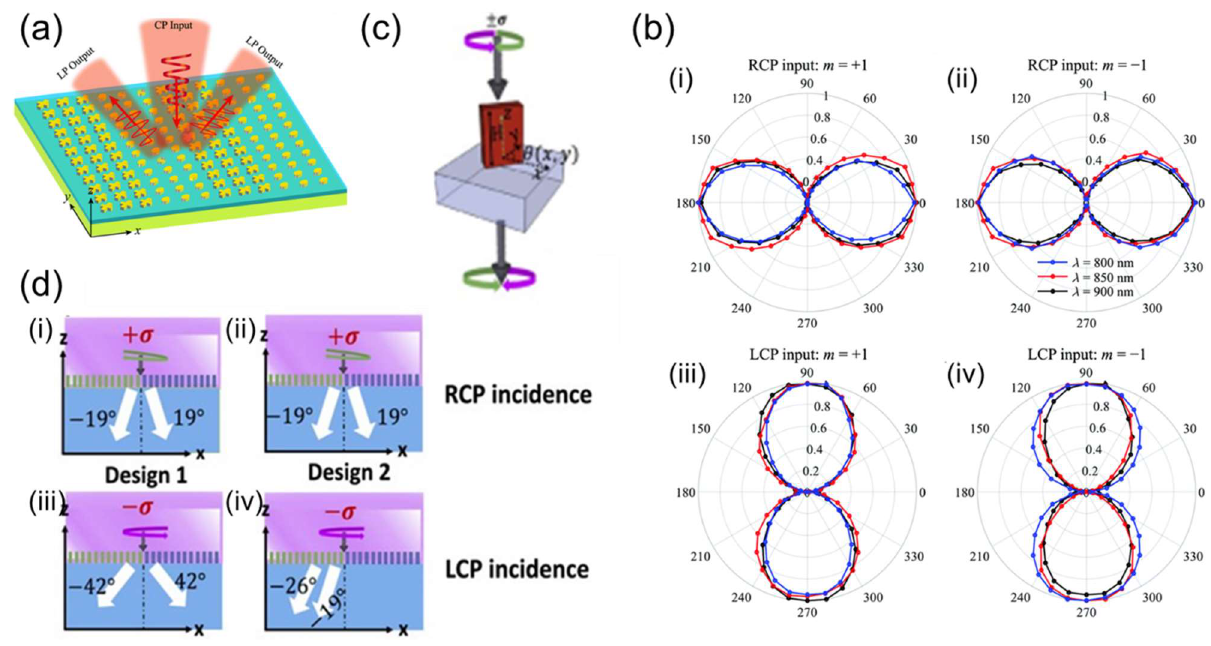
Figure 9. ( a ) Schematic diagram of a metasurface beam splitter with a QWP function [100]. ( b ) Experimentally measured polarization states in the plane perpendicular to the wave vector in ± 1 diffraction orders of RCP ( i , ii ) and LCP ( iii , iv ) light excitation at wavelengths of 800, 850, and 900 nm, respectively [100]. ( c ) Schematic diagram of the beam splitter design [101]. ( d ) ( i − iv ) Two different designs are proposed, where the beam−splitting angles on both sides of the normal can be tuned by switching the handedness of the incident light [101]. Table 3. Parameters of polarization-sensitive metasurface beam splitters described in this section.